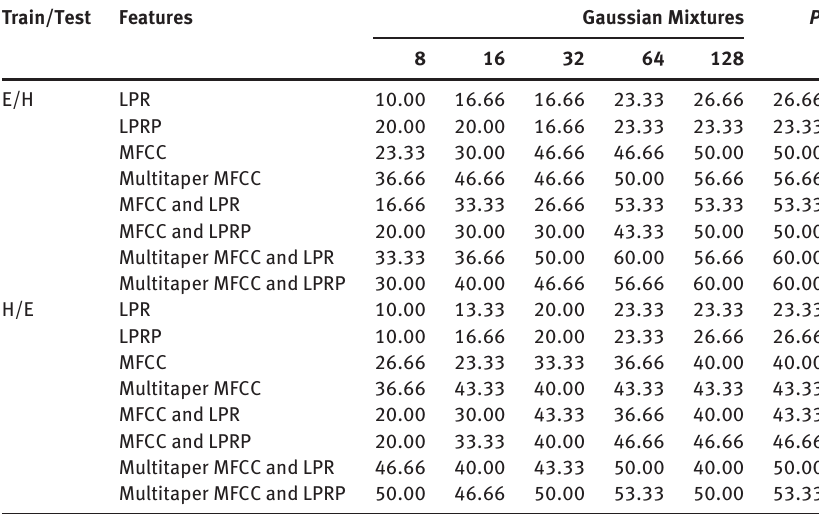
Table 2. The Crosslingual Speaker Identification Performance using LPR, LPRP, MFCC, and Multitaper MFCC-Based Individual and Combined System. P Identification Performance among the Number of Gaussian